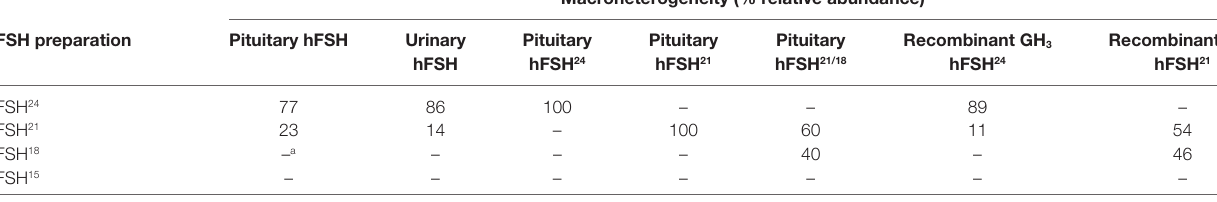
TABLe 1 | Macro- and microheterogeneity of hFSH preparations.